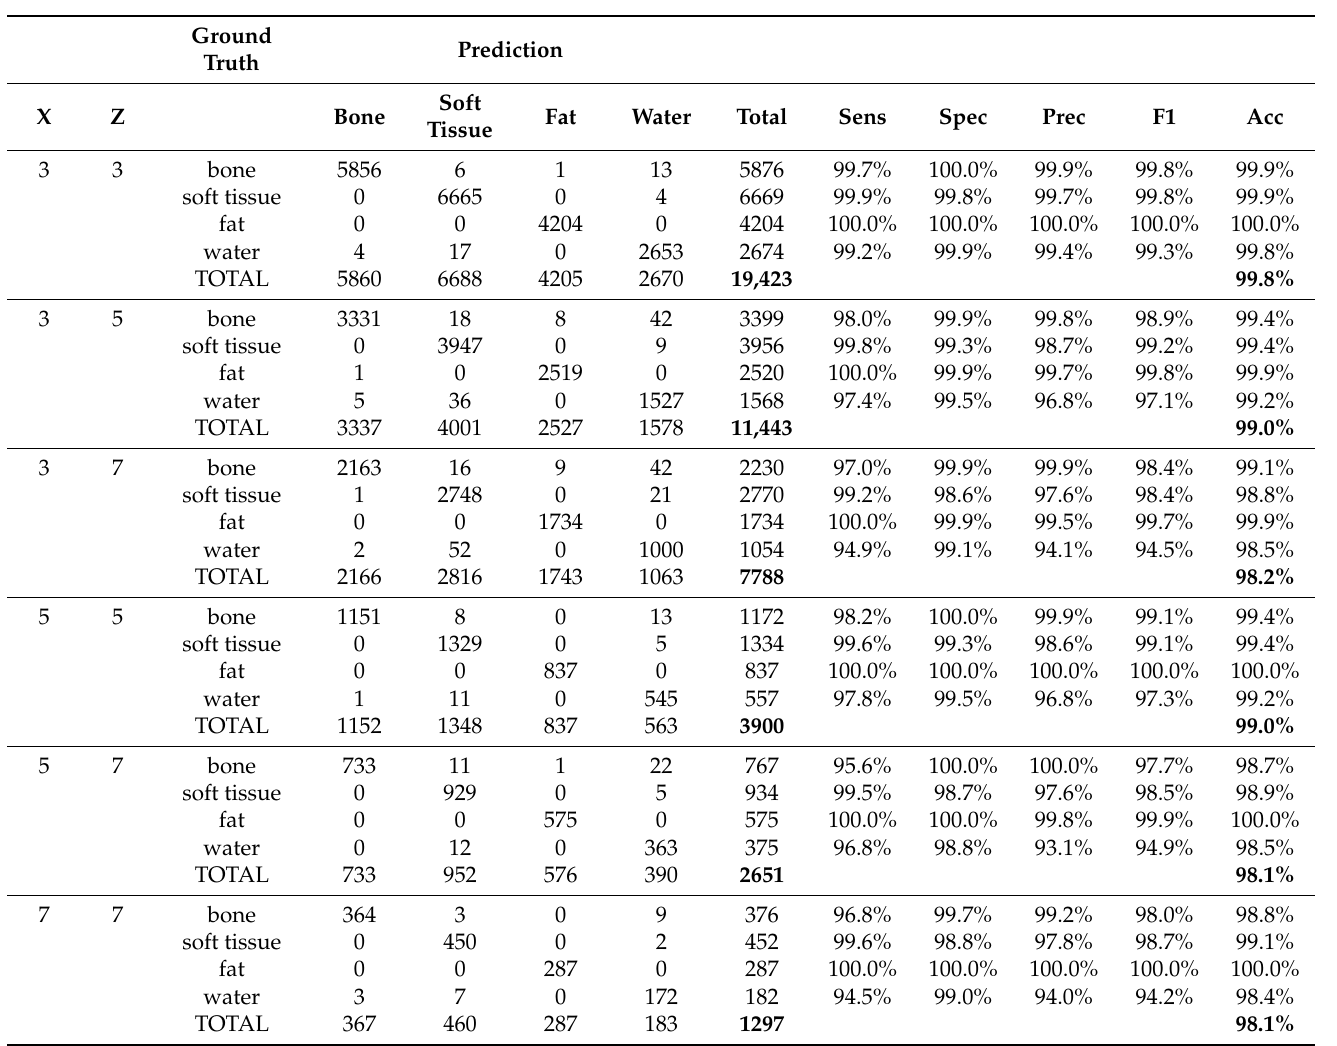
Table 2. Confusion matrices and detailed test performance characteristics a at different combinations of X and